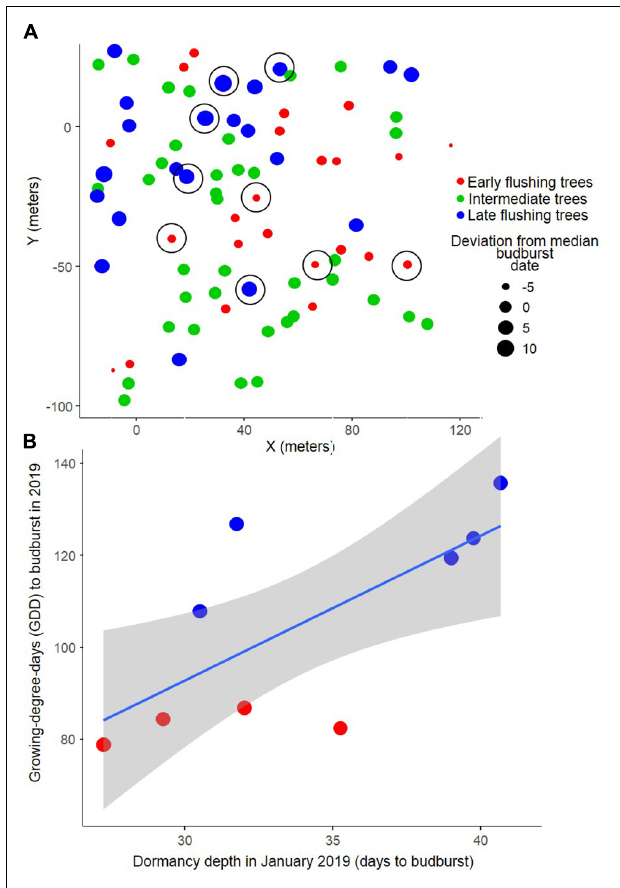
FIGURE 2 | Earlier flushing beech trees are not spatially aggregated (A) and have lower bud dormancy depth already in mid-winter (B) . Late flushing trees (blue), intermediate trees (green), and early flushing trees (red), presented in terms of (A) their spatial arrangement, and (B) dormancy depth in winter regressed against the growing degree days (GDD) sums at budburst (from January 1) for the sampled trees in 2019. Five latest and four earliest trees were used (location of sampled trees marked by black circles in panel (A) . Grey polygons indicate 95% confidence